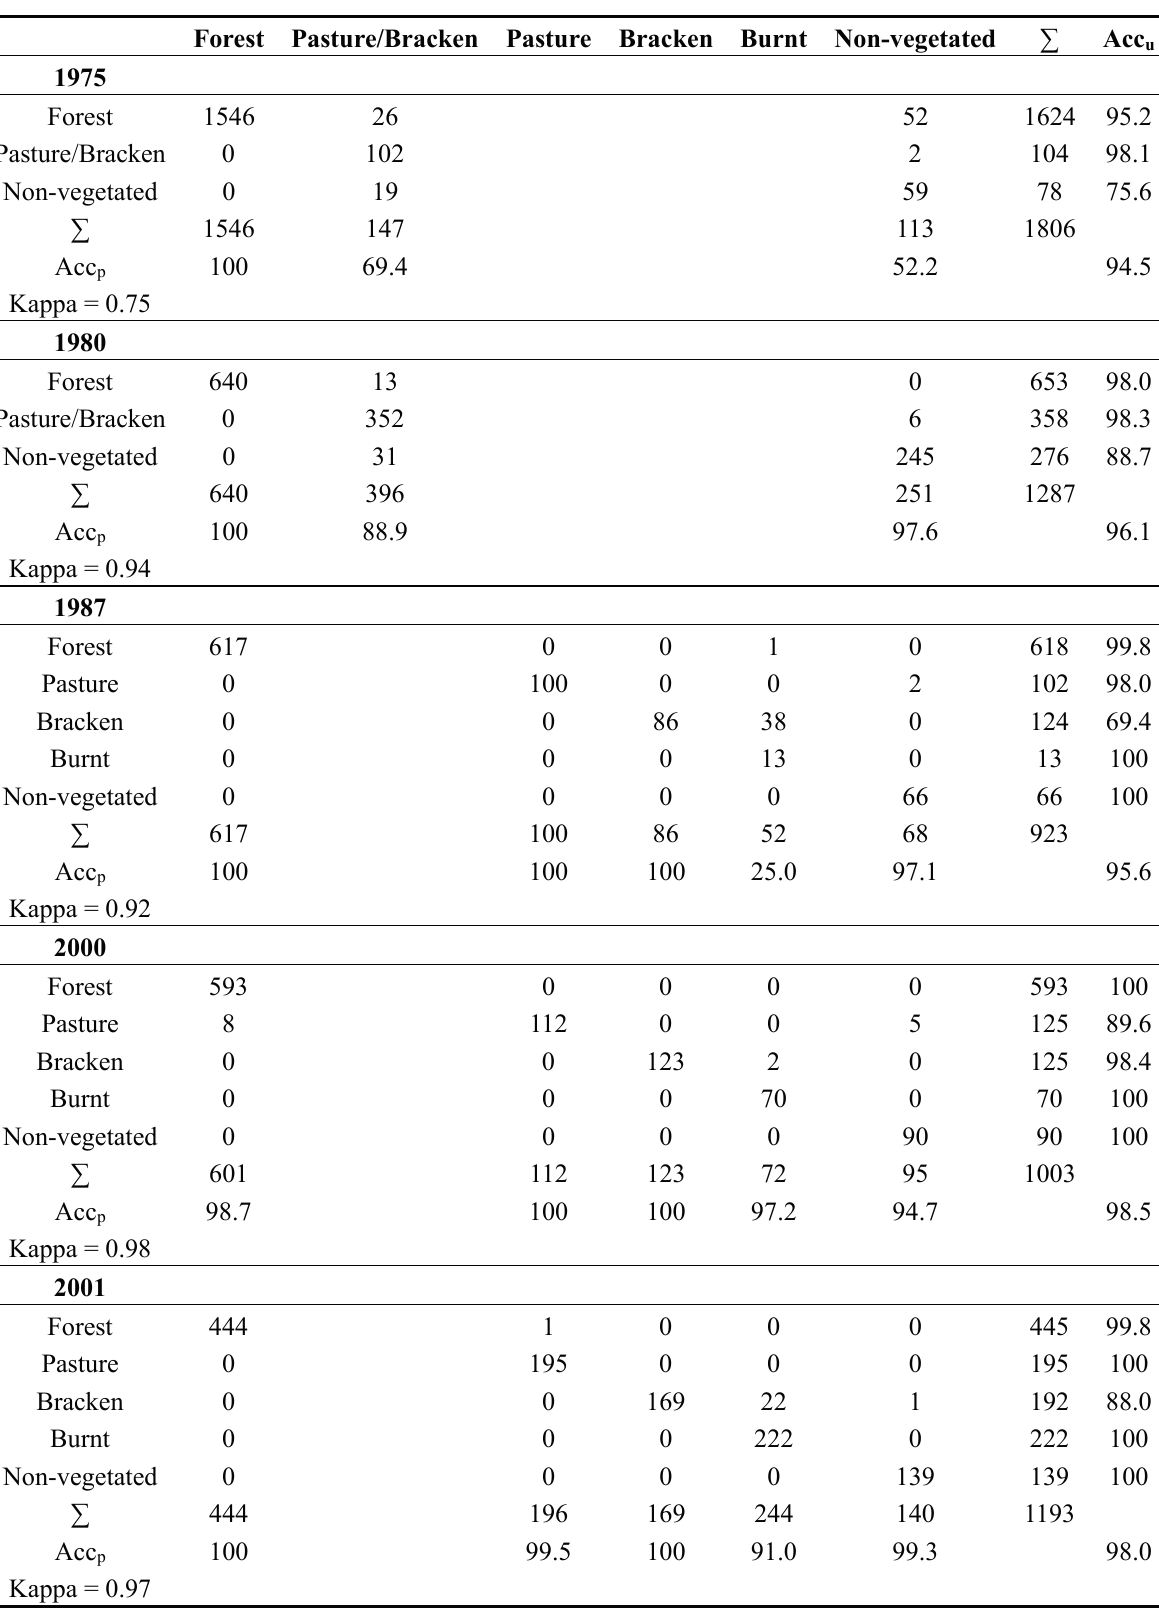
Table 5. Accuracy assessment of maximum likelihood classifications (MLCs). Rows contain results from the MLCs and columns are the reference